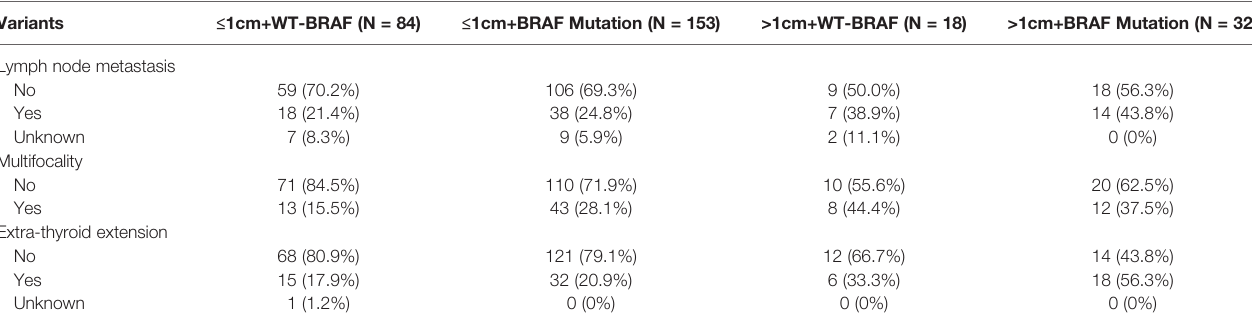
TABLE 4 | The clinical characteristics of PTC patients by tumor size and BRAF V600E mutation status (n =